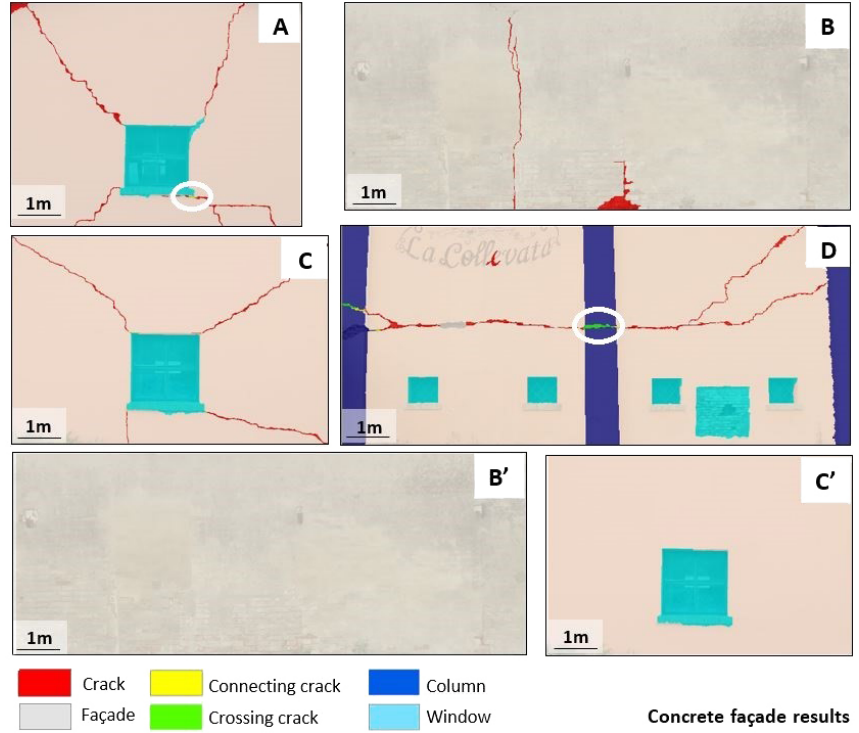
Figure 8. Results of applying the concrete rule set on six concrete façade. (b’) and (c’) were edited in order to remove the damage feature. (a) and (d) highlight cases of connecting and crossing cracks. (a) highlights with a circle the location of a connection, the small nature of a crack connecting with a window makes it hard to visualize it in the illustration. (d) illustrates a crack crossing a column as a green object (highlighted by circle). Scale approx.